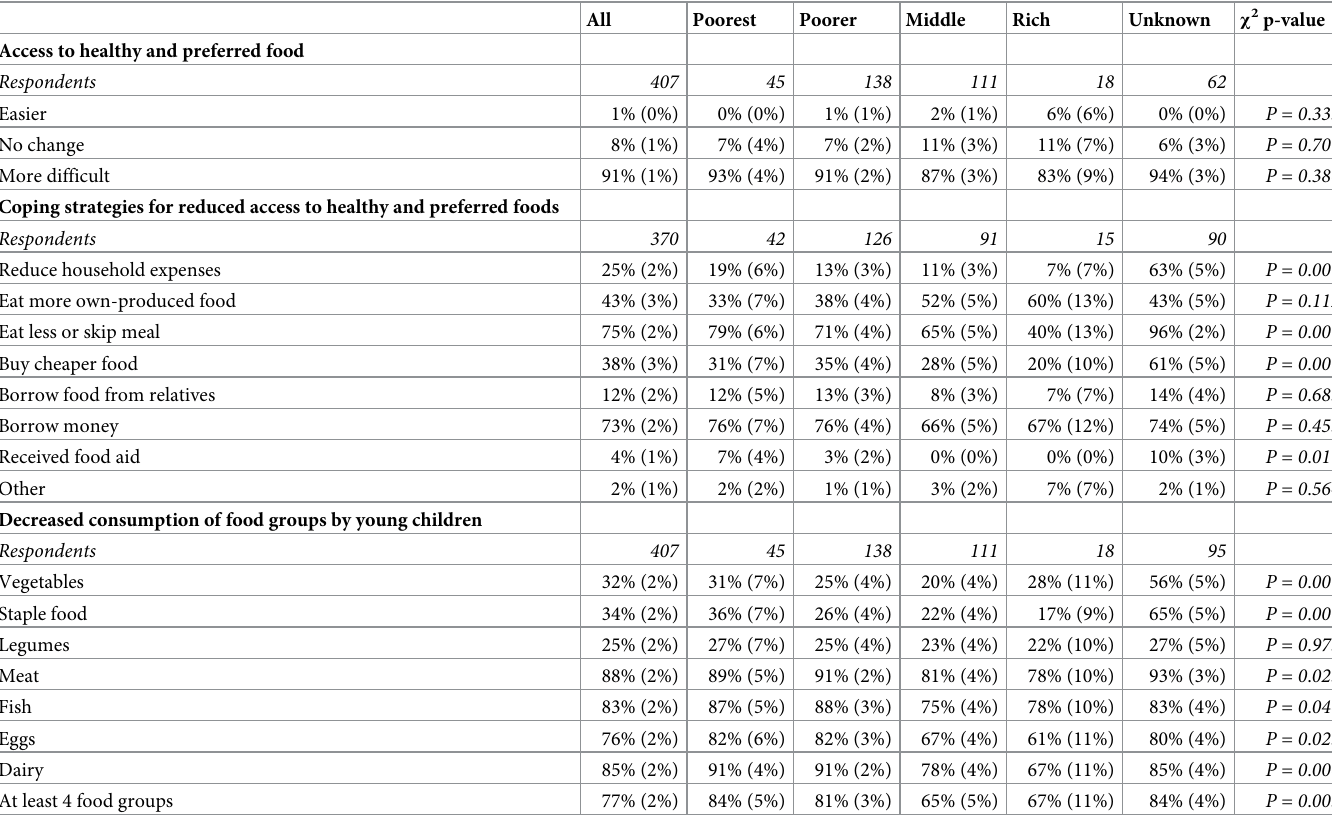
Table 4. Impact of COVID-19 on access to healthy and preferred foods, and consumption of different foods by children.